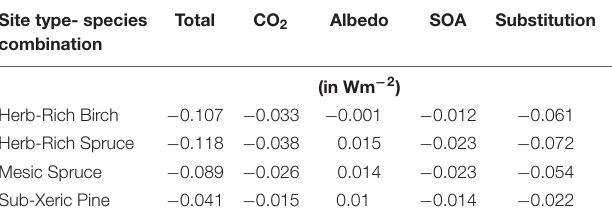
Values are relative to clear cut area. Negative = cooling, positive =